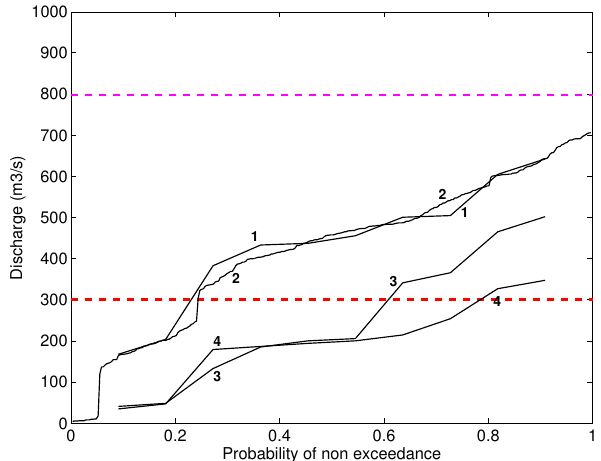
Figure 14. Flood risk analysis based on the simulation of rainfall runoff models forced with the MNH-MWF ensemble. The solid lines represent the estimation of the probability distribution of peak discharge for the four models: RIBS deterministic (1), RIBS proba- bilistic (2), DRiFt deterministic (3) and HBV deterministic (4). The dashed red line is the warning threshold and the dashed magenta line corresponds to the observed peak